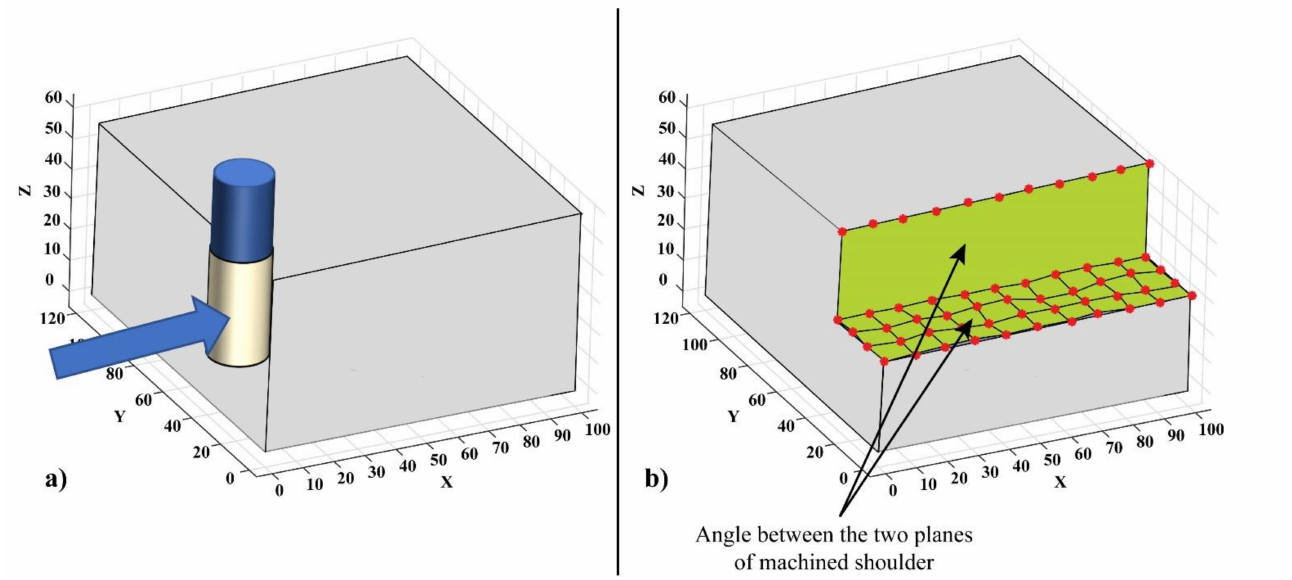
Figure 6. ( a ) Contouring process and ( b ) angle between the two planes of the machined shoulder. Table 1. Results of contour